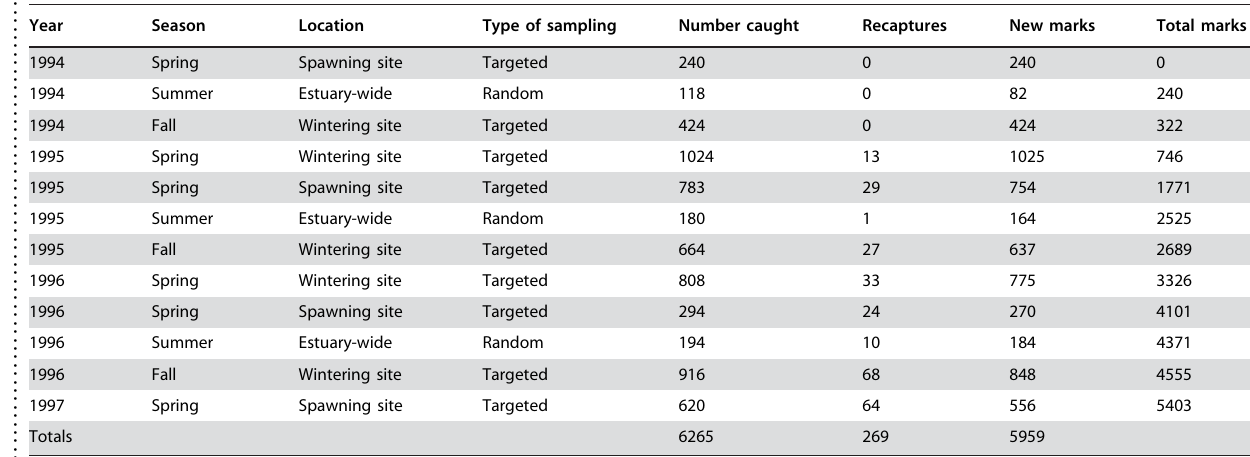
Table 1. Numbers of shortnose sturgeon marked and recaptured in targeted and random sampling during the study. .. ... .... ... ... .... ... ... .... ... ... .... ... ... .... ... ... .... ... ... .... ... ... .... ... ... .... ... ... .... ... ... .... ... ... .... ... ... .... ... ... .... ... ...